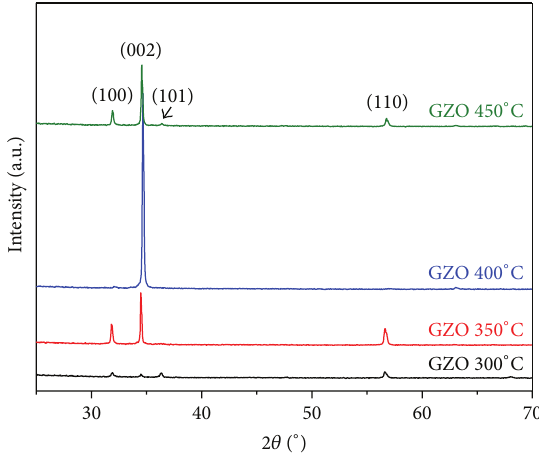
Figure 1: X-ray diffraction patterns of GZO film as a function of deposition temperature.